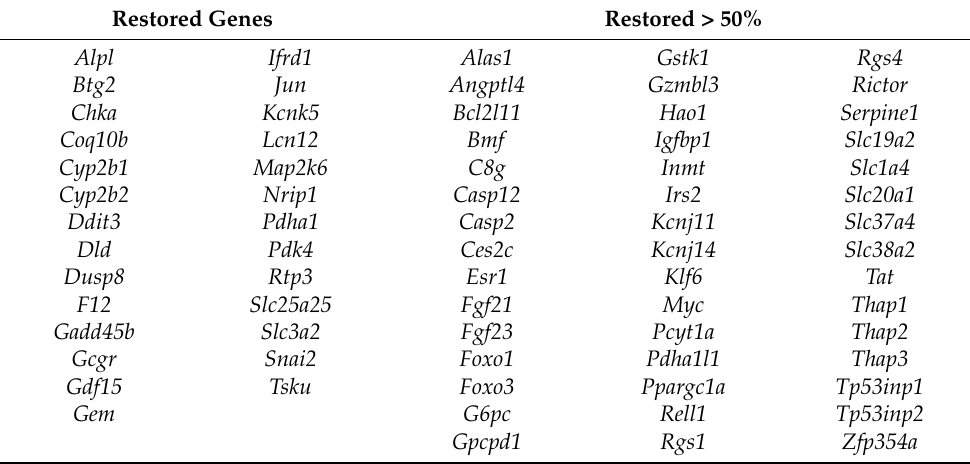
Table 3. Genes restored in T2D rats to the expression levels found in healthy conditions (gene expression levels from healthy untreated animals) after the 28 mg/kg BW C γ + 20 mg/kg BW lupanine treatment. Restored Genes Restored > 50% Alpl Ifrd1 Alas1 Gstk1 Rgs4 Btg2 Jun Angptl4 Gzmbl3 Rictor Chka Kcnk5 Bcl2l11 Hao1 Serpine1 Coq10b Lcn12 Bmf Igfbp1 Slc19a2 Cyp2b1 Map2k6 C8g Inmt Slc1a4 Cyp2b2 Nrip1 Casp12 Irs2 Slc20a1 Ddit3 Pdha1 Casp2 Kcnj11 Slc37a4 Dld Pdk4 Ces2c Kcnj14 Slc38a2 Dusp8 Rtp3 Esr1 Klf6 F12 Slc25a25 Fgf21 Myc Thap1 Gadd45b Slc3a2 Pcyt1a Gcgr Snai2 Foxo1 Pdha1l1 Thap3 Gdf15 Foxo3 Rgs1